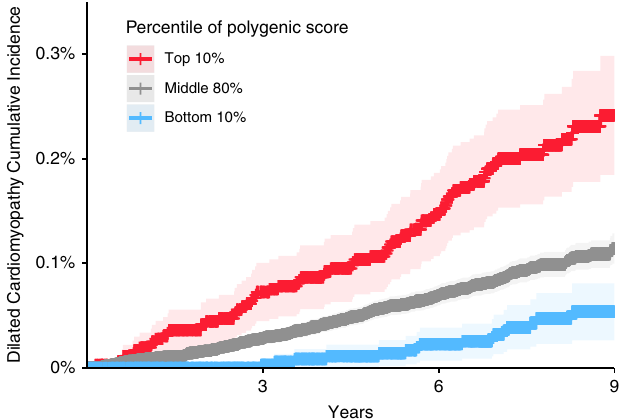
Fig. 3 The LVESVi polygenic score in fl uences the risk for incident dilated cardiomyopathy. The cumulative DCM incidence (de fi ned as 1 minus the Kaplan – Meier survival estimate) is plotted for individuals in the bottom tenth percentile (blue), middle 80% (gray), and top tenth percentile (red) for the LVESVi polygenic score. The 95% con fi dence intervals (derived from the standard error of the cumulative hazard) are represented with lighter colors. The x -axis represents the number of years since enrollment in the UK Biobank. The y -axis represents the cumulative incidence of